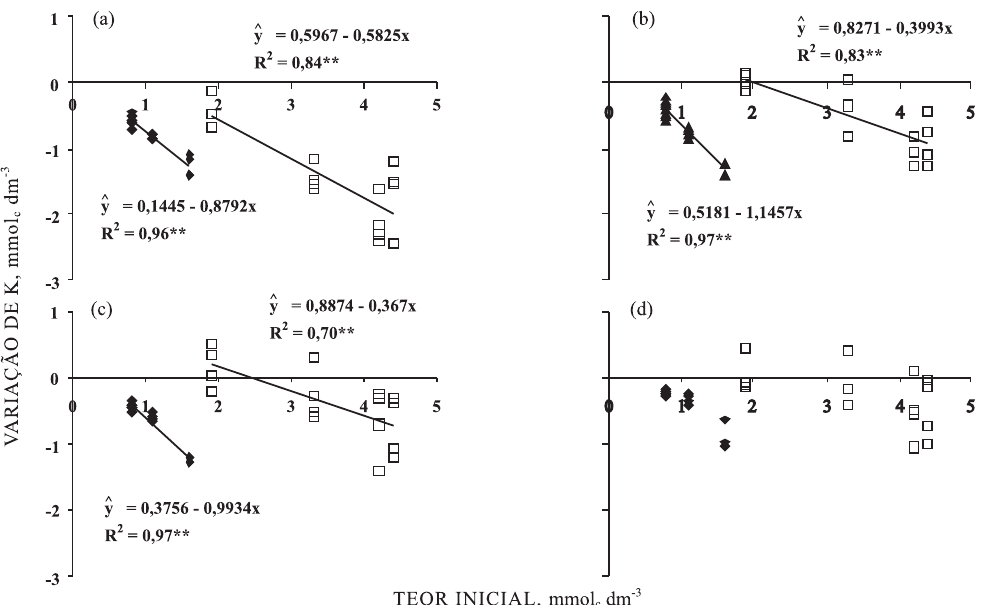
Figura 3. Correlação entre a variação do teor de potássio e o teor inicial de potássio trocável do solo proveniente da adubação residual e da complementar com 80 kg ha -1 de K profundidades de 0–5, 5–10, 10–20 e 20–40 cm (a, b, c e d, respectivamente). ( ): Textura média ( ): Textura argilosa. **: significativo 1